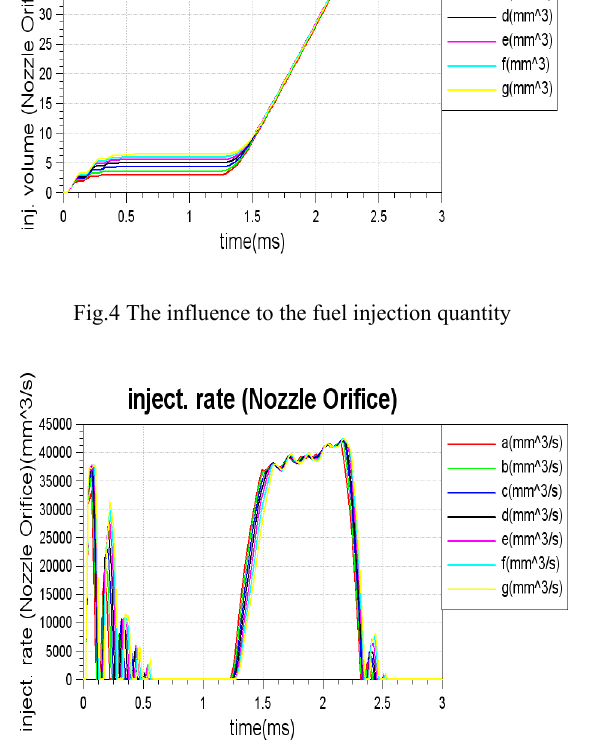
Fig.5 the influence to the injection